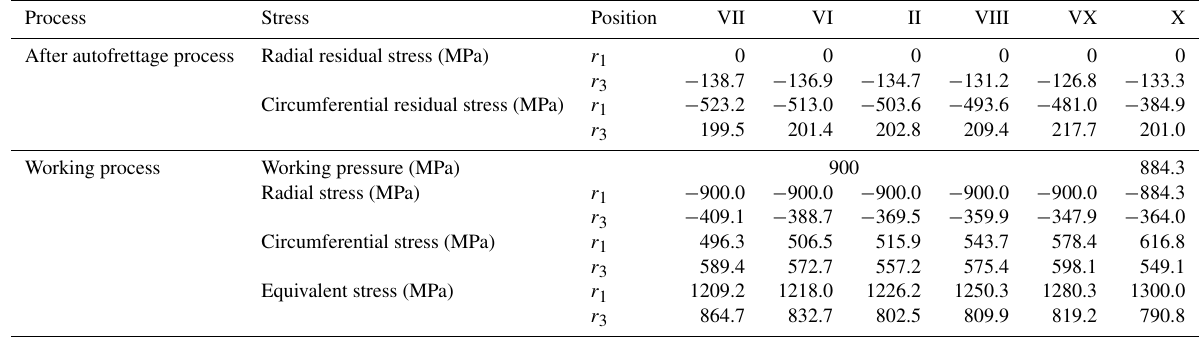
Table 6. Results for different external diameters of the insert die and stress ring. Process Stress Position After autofrettage process Radial residual stress